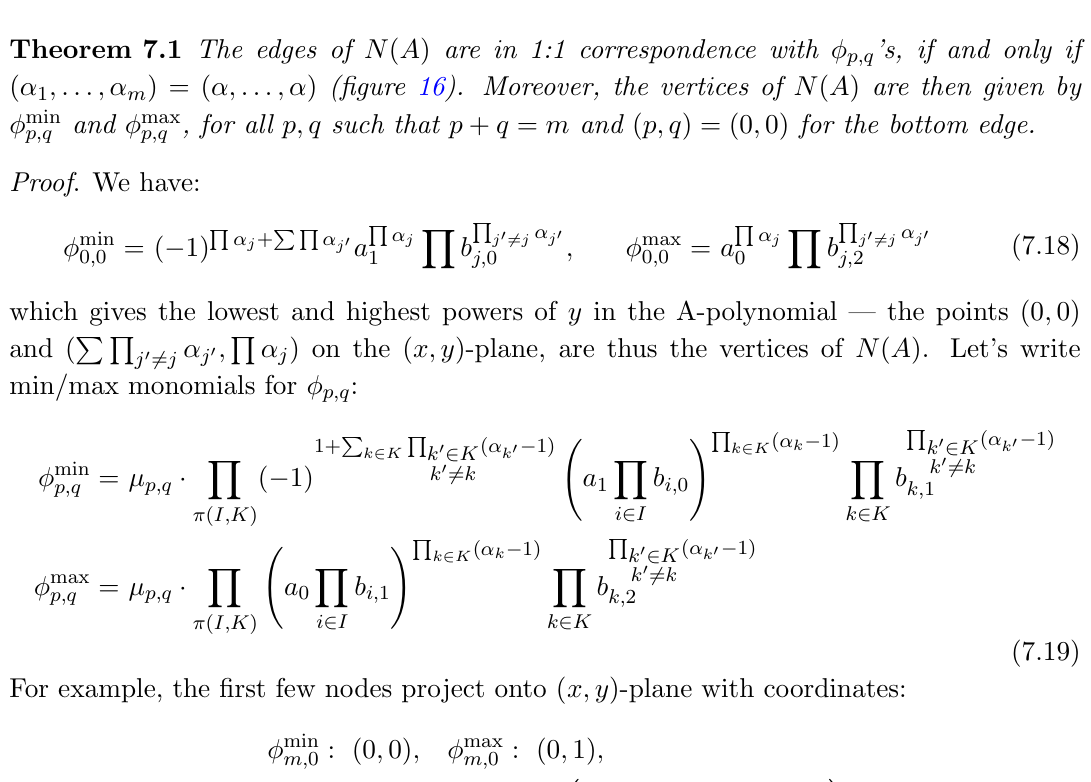
Figure 16 . N ( A ) for diag( (cid:11); : : : ; (cid:11) ): each (cid:30) i;j projects onto the corresponding edge, such that the min/max monomials of (cid:30) i;j are in bijection with the vertices of N ( A ); (cid:30) 0 := (cid:30) 0 ; 0